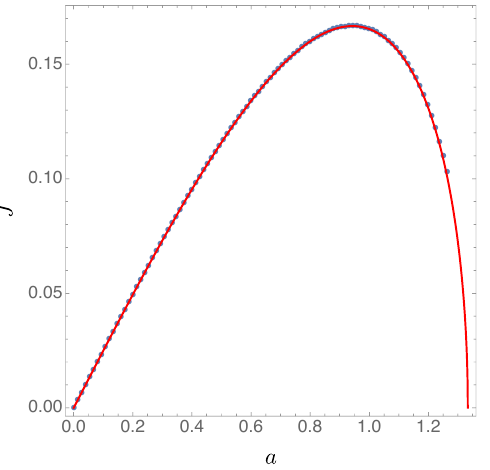
Figure 10 . Total angular momentum as a function of a , for the marginal case ( n = 1). The solid red line is the result for the spinning top shown in (cid:12)gure